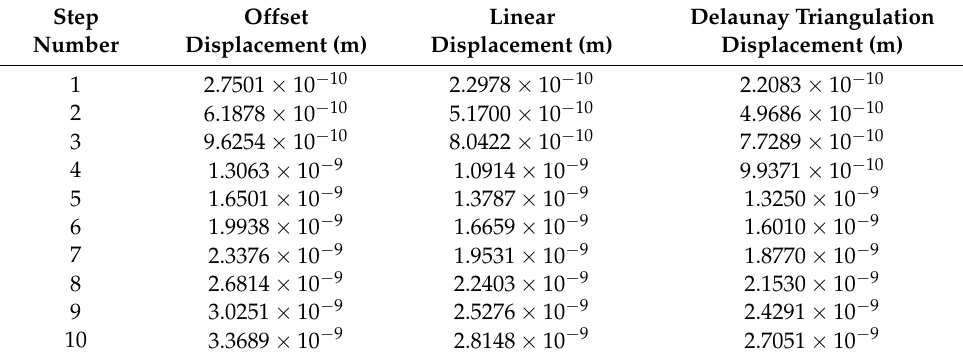
Table 3. Transverse displacement change table.